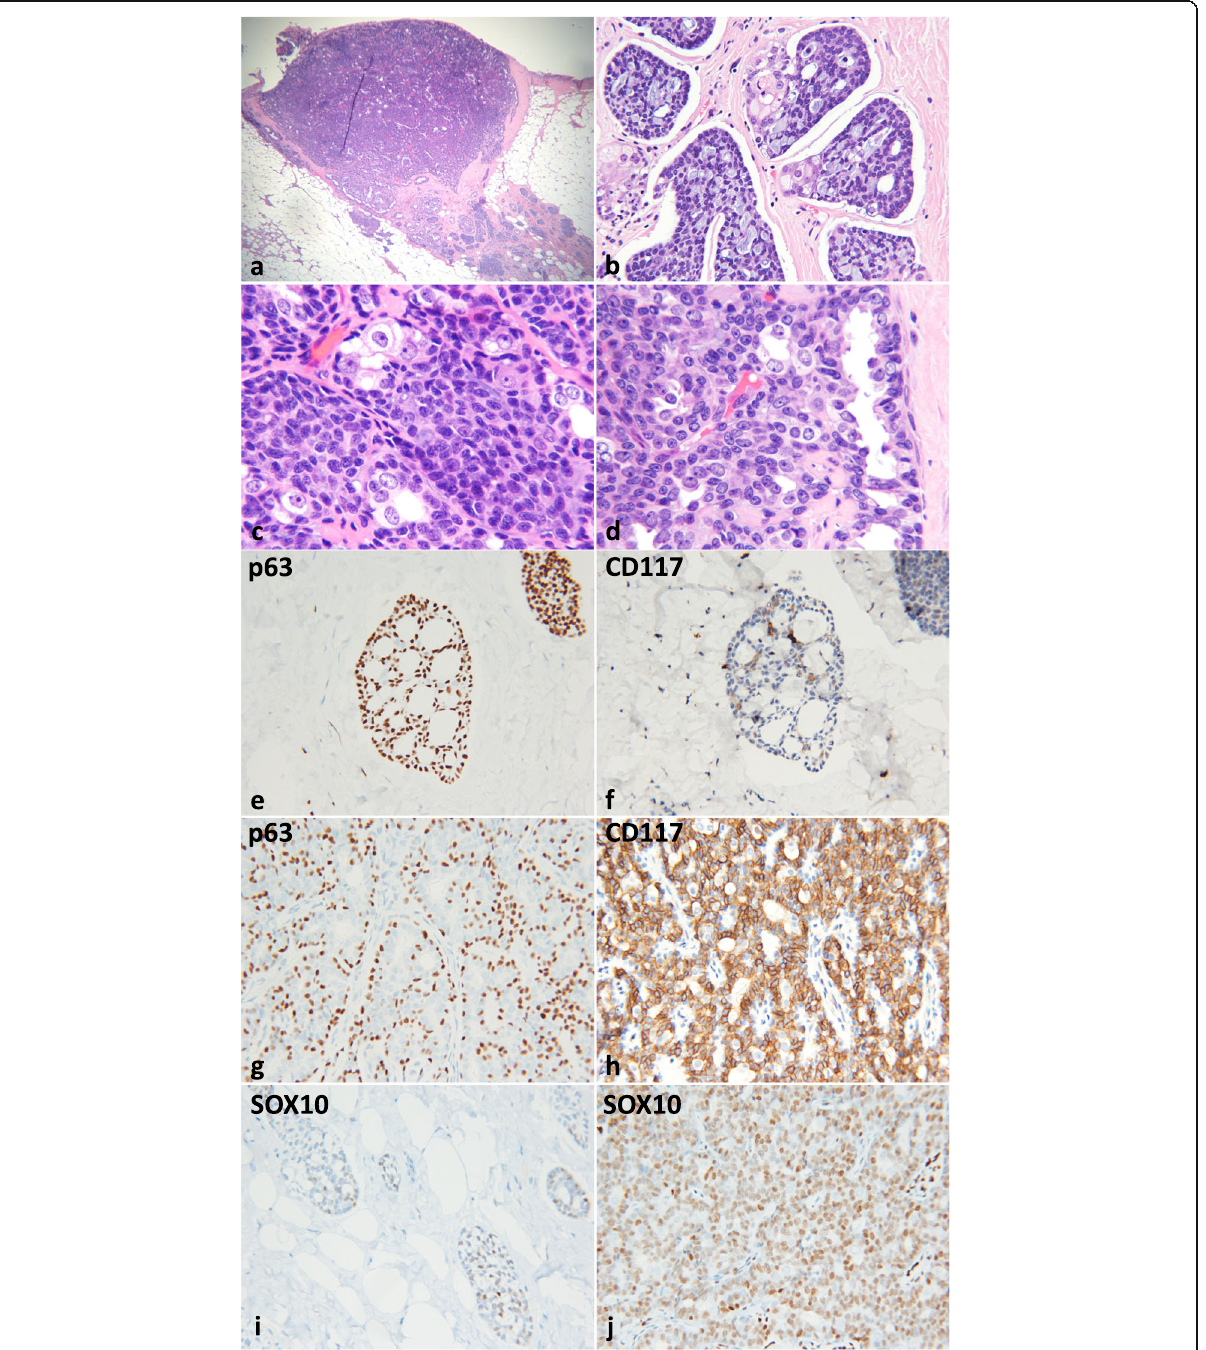
Fig. 2 Microscopic and immunohistochemical examinations for the right breast lesion. a A large papillary lesion was present within a dilated duct. b Groups of cribriform basaloid cells were present within the thickened fibrous septae adjacent to the papillary lesion, which showed bland basaloid cells with prominent cribriform architecture, intraluminal mucin and foci of sebaceous differentiation. c High power examination of the papillary lesion revealed similar basaloid cells with area of sebaceous differentiation. d Periphery of the papillary lesion showed intact layer of myoepithelial cells. e Immunostain for p63 and ( f ) CD117 in glandular structures showed positivity for dual population of myoepithelial cells and luminal epithelial cells. g Immunostain for p63 ( g ) and ( h ) CD117 in the papillary lesion also highlighted dual population of myoepithelial cells and luminal epithelial cells. i Both the glandular structures and the ( j ) papillary lesion were also positive for SOX10 immunostain. (Hematoxylin- eosin, original magnification ×2 [ a ], × 20 [ b ], ×40 [ c , d ]; Immunohistochemistry, original magnification × 20 [ e , f , g , h ]. × 20 [ i , j